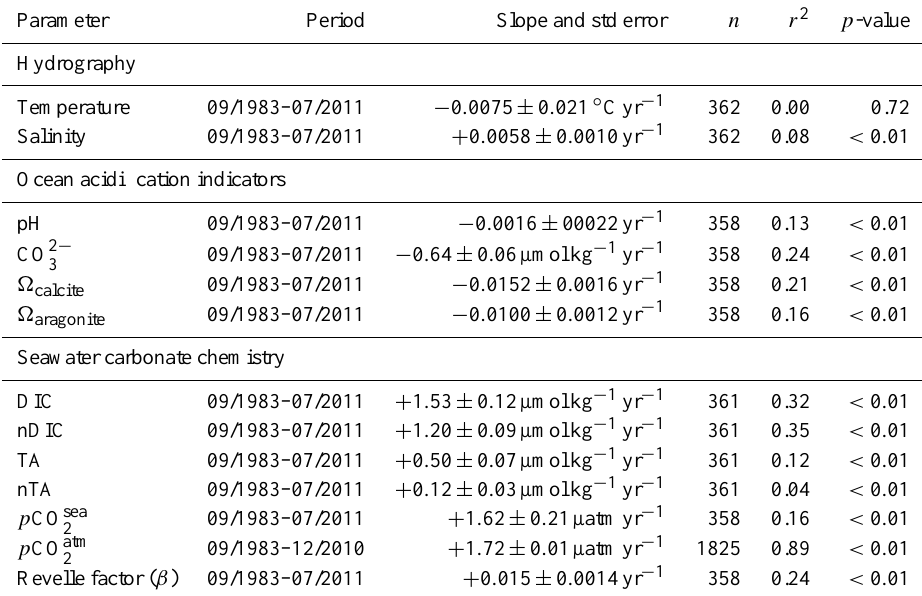
Table 1. Long-term trends (1983–2011) of surface hydrography and seawater carbonate chemistry with regression statistics (slope and error, n , r 2 and p -value). This includes surface seawater temperature, salinity, DIC, nDIC, TA, nTA, atmospheric p CO 2 ( p CO atm calculated seawater p CO 2 ( p CO sea ) and Revelle factor ( β ) from the BATS (31 ◦ 50 0 N, 64 ◦ 10 0 W)/Hydrostation S (32 ◦ 10 0 N, 66 ◦ 30 0 W) sites 2 in the North Atlantic Ocean. Please see text for details on the CO 2 -carbonic acid system computation and salinity normalisation procedures. Observations of atmospheric p CO 2 data come from two atmospheric monitoring sites (Terceira Island, Ac¸ores, September